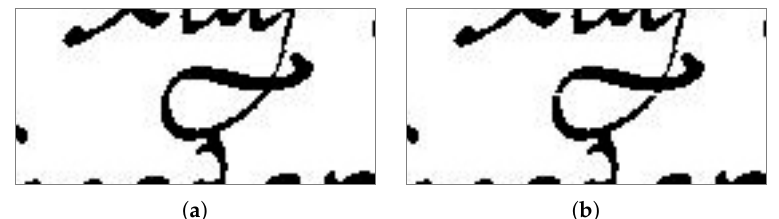
Figure 5. Examples of insurmountable obstacle: ( a ) An example of an insurmountable obstacle, ( b ) An example of a modified insurmountable obstacle: note the path of white pixels inserted in the middle of the ink track for allowing crossing the